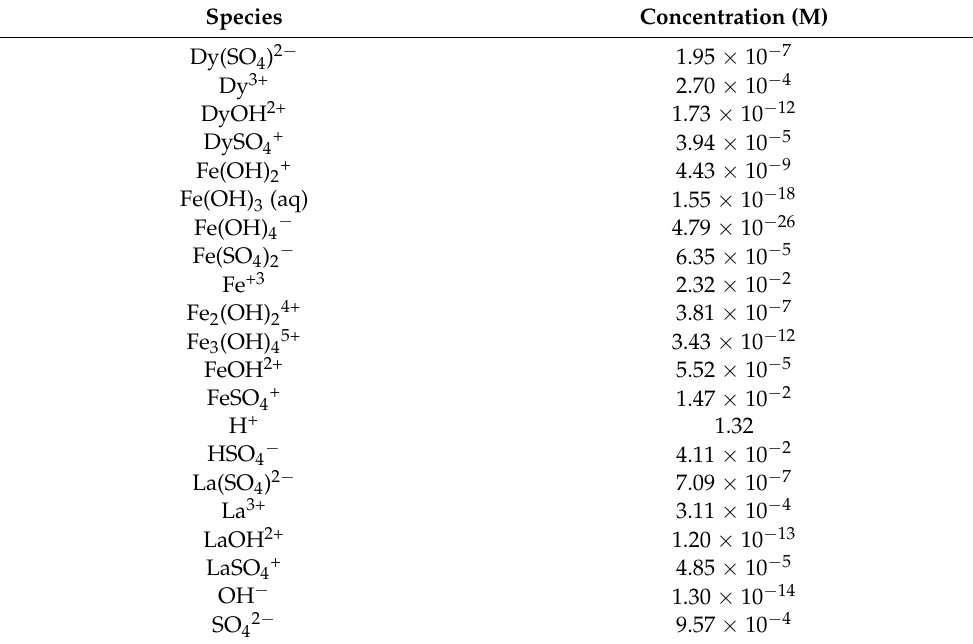
Table 2. Based on Visual Minteq 3.1 simulations, iron, lanthanum, and dysprosium were identified in 10 g/L ferric sulfate heptahydrate, 50 ppm lanthanum, and 50 ppm dysprosium at pH = 0 and an input of 10 g/L ferric sulfate heptahydrate, 50 ppm lanthanum, and 50 ppm